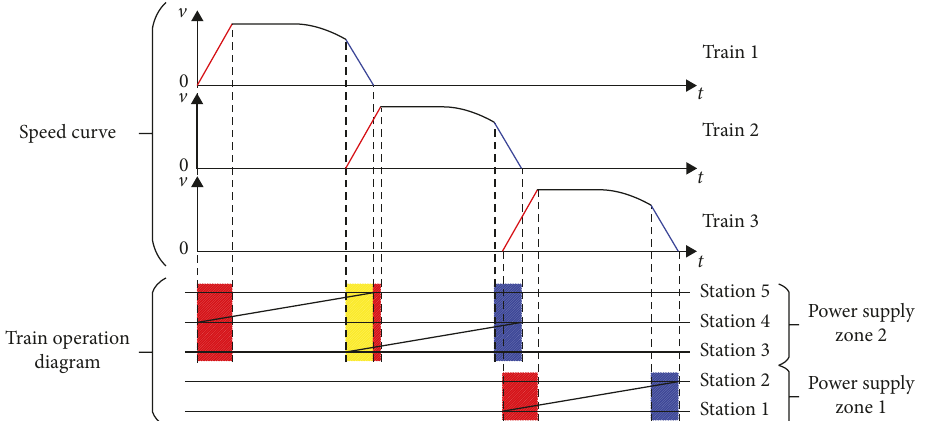
Figure 2: Utilization of regenerative braking energy for two trains running in the same